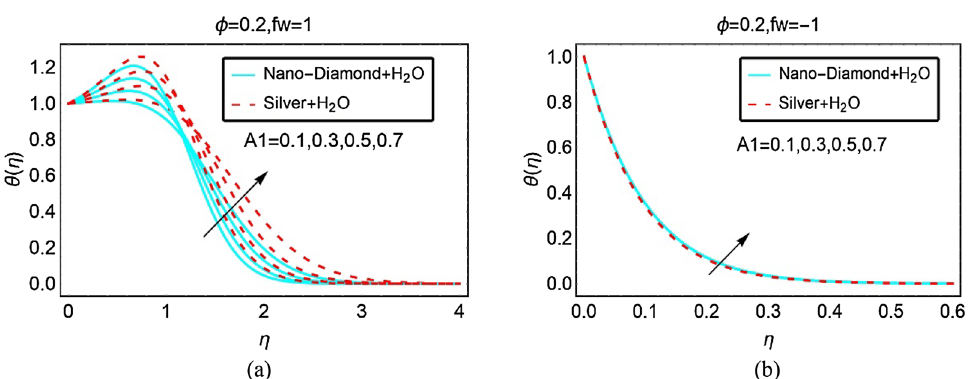
Figure 6. The Temperature against ( a ) Suction and ( b ) Injection for varying A 1 .